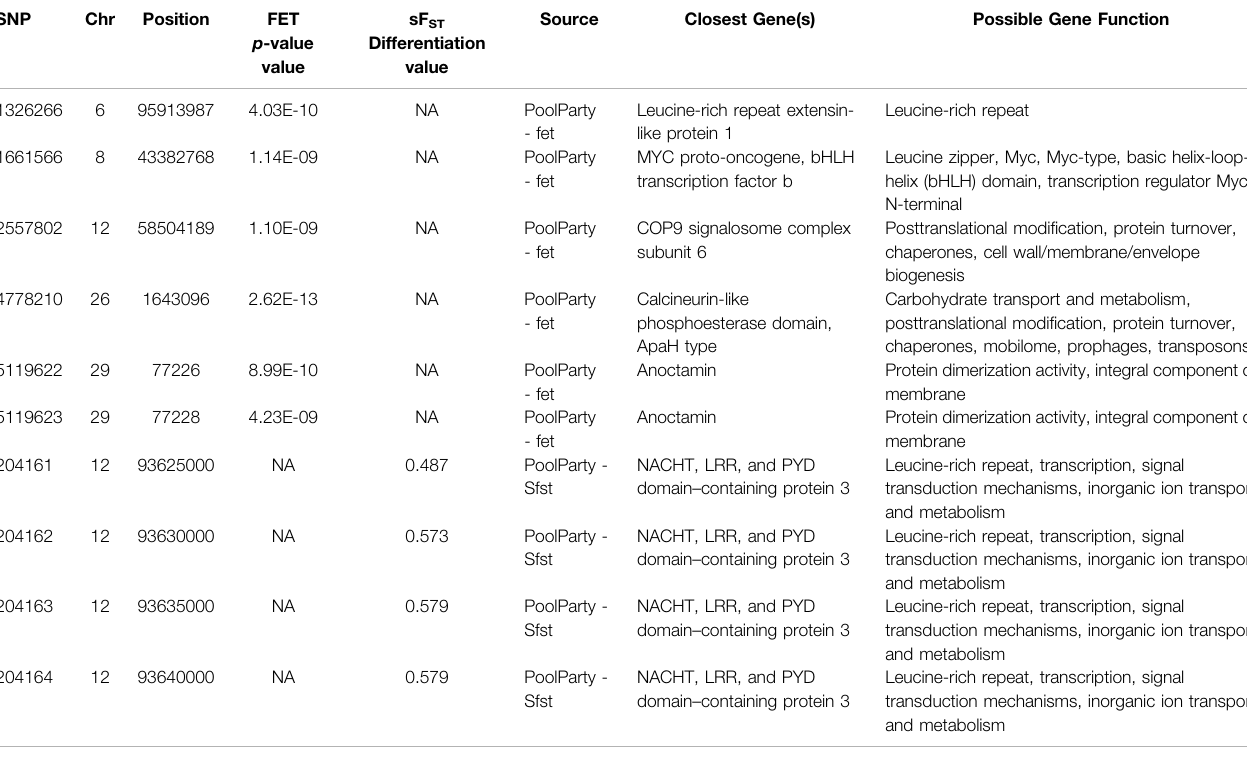
TABLE1| Genomicpositionandclosestgeneannotationsforsigni fi cantmarkersfromFisher'sExactTest(FET)andslidingwindowFst(sFst)analysesonchromosome(Chr) Omy12.